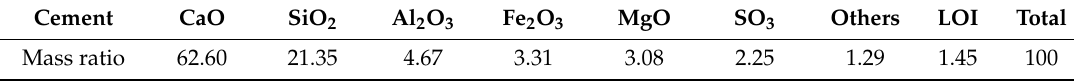
Table 1. Cement composition from this study